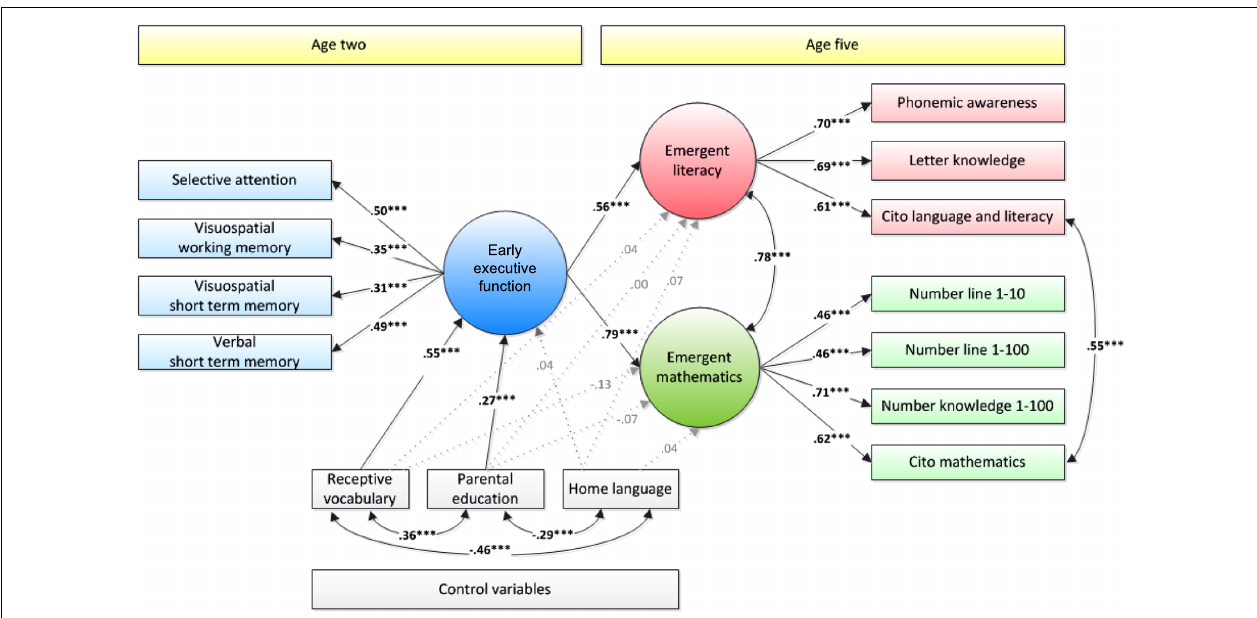
FIGURE 1 | Structural Equation Model with early executive function (EF) at age two as a predictor of emergent mathematics and literacy at age five. Standardized estimates are presented. Dotted, gray lines represent non-significant coefficients. ∗ p < 0.05, ∗∗ p < 0.01, ∗∗∗ p < 0.001.